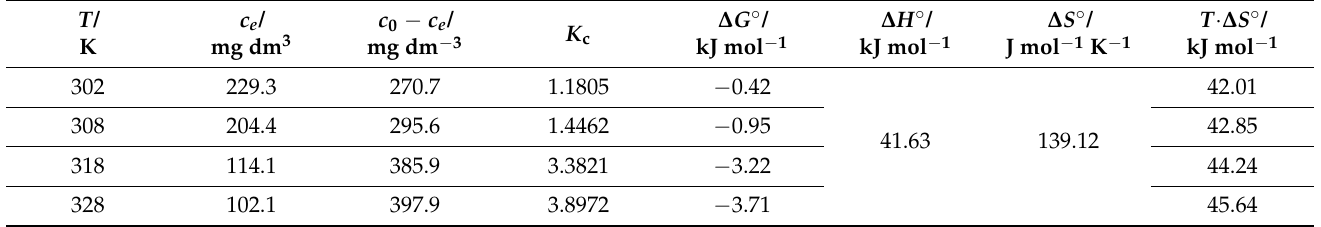
Table 4. Thermodynamic parameters for the adsorption of RB5 dye on activated carbon for pH 0 = 4.00.